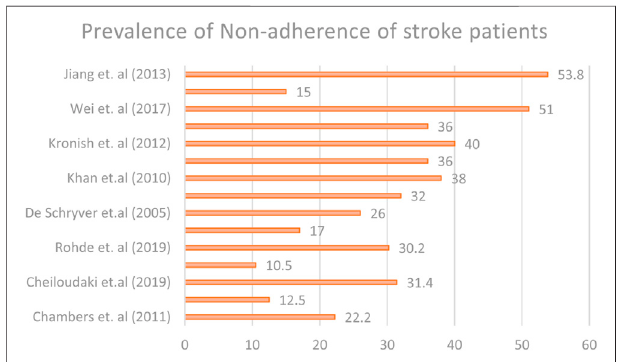
FIGURE 4 | Prevalence of